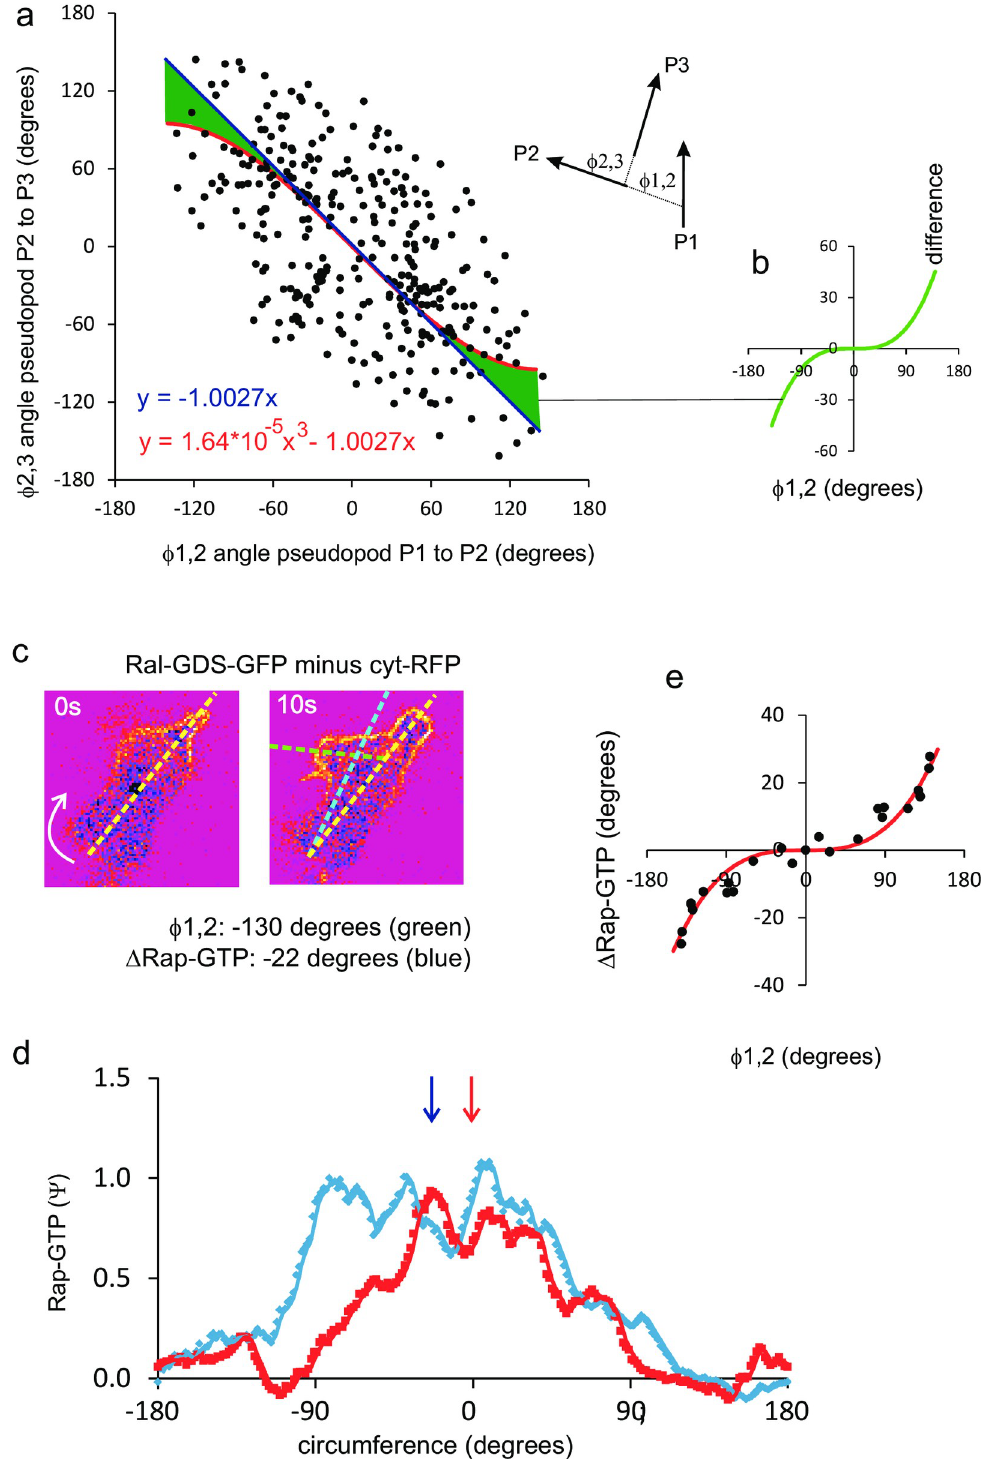
Fig 8. Maintenance and adjustment of the polarity axis by pseudopods in the front. a. angles between three pseudopods; a perfect inverse relationship implies that P1 and P3 are extended in a similar direction, irrespective of the direction of P2. The data were analyzed by linear and polynomial regression analysis, yielding y = -1.0027x, RSS = 4.07 � 10 5 and AIC c1 = 4841 for linear regression with one parameter and y = 1.64 � 10 − 5 � x 3 –1.0027x, RSS = 3.91 � 10 5 and AIC c2 =